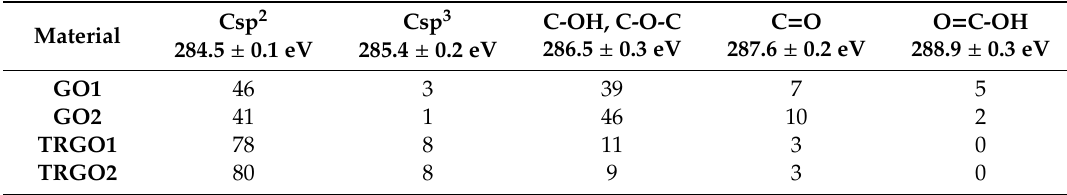
Table A1. Distribution of carbon and oxygen bonds both for graphite oxide and thermally reduced graphene oxide by XPS,